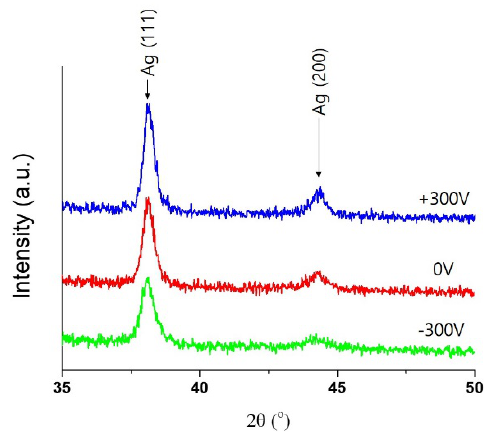
Figure 9. XRD data of the Ag films deposited at the electric biases of −300, 0 and +300 V in the 2θ range of 35°– 50°. The FWHMs of (111) peaks for −300, 0 and +300 V are 0.53, 0.47 and 0.44, respectively.